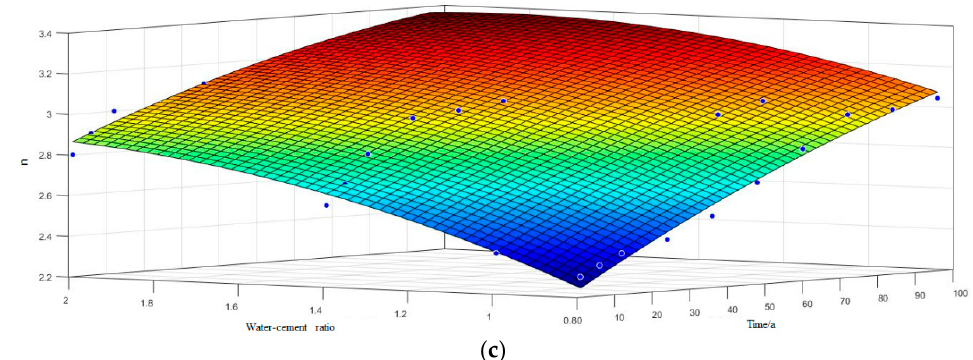
Figure 6. Fitting Law of ( a ) ε A ; ( b ) ε P ; ( c ) n.